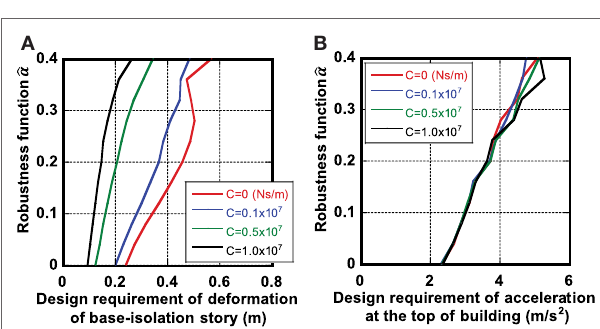
FIGURE 8 | Robustness function with respect to design requirement, (A) deformation of the base-isolation story and (B) absolute acceleration at the top of the main structure (Tokyo area).